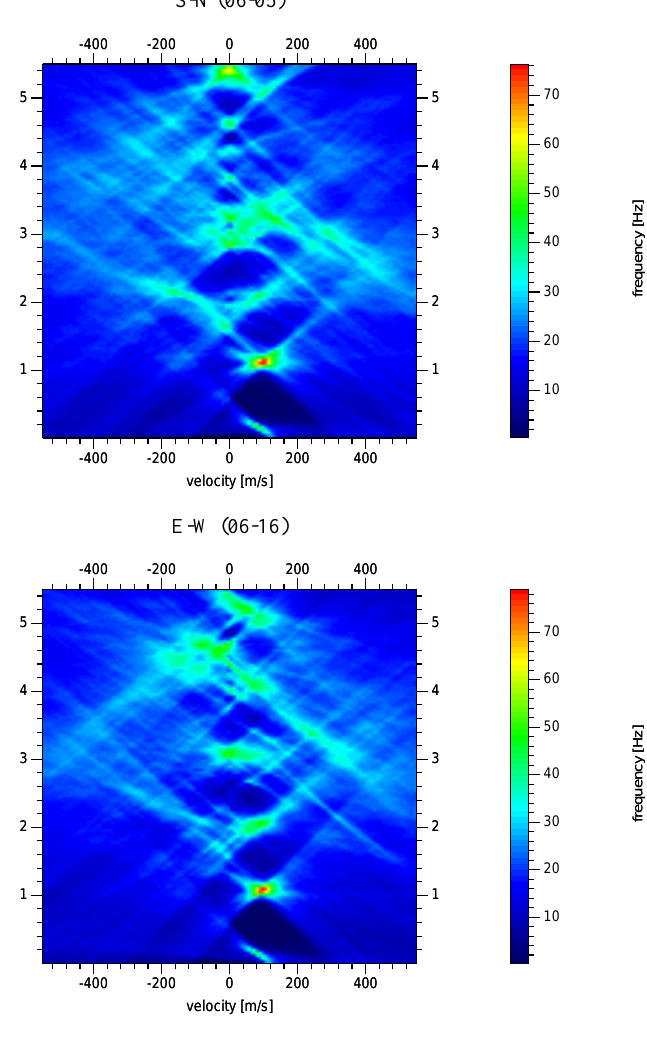
contains two families of parallel maxima lines with differ- ent slopes as one could expect for nonstationary drift. High- frequency part of maxima lines diffuse in the noise which starts to dominate there since noise power spectrum is white. We also marked with arrows two maxima lines and shaw 1φ = 0 line. The intersection point of the maxima line with this line gives frequency value of maximum point in the RT domain shown in lower panel of Fig. 8. Figure 9 ilustrates the RT of phase-frequency distributions depicted in Fig. 6 for two pairs of GPS antennas – upper panel S-N pair and lower E-W, respectively. The isolated maxima correspond to maxima lines on the phase-frequency distribution but now we can determine a velocity that they define. Taking into account the relation between slope